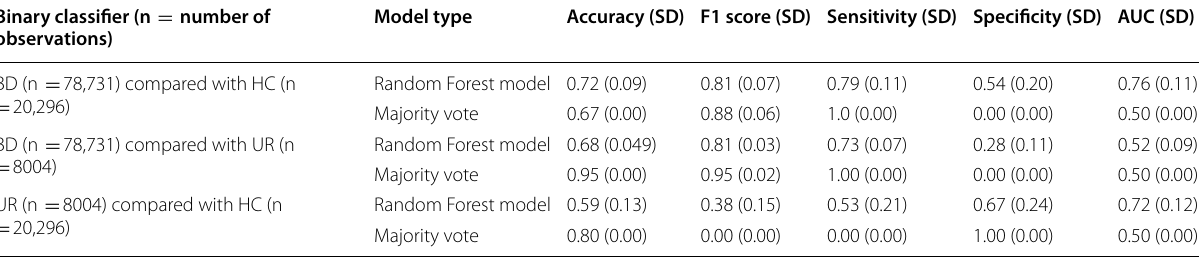
121), unaffected relatives (UR) (n = 180 =